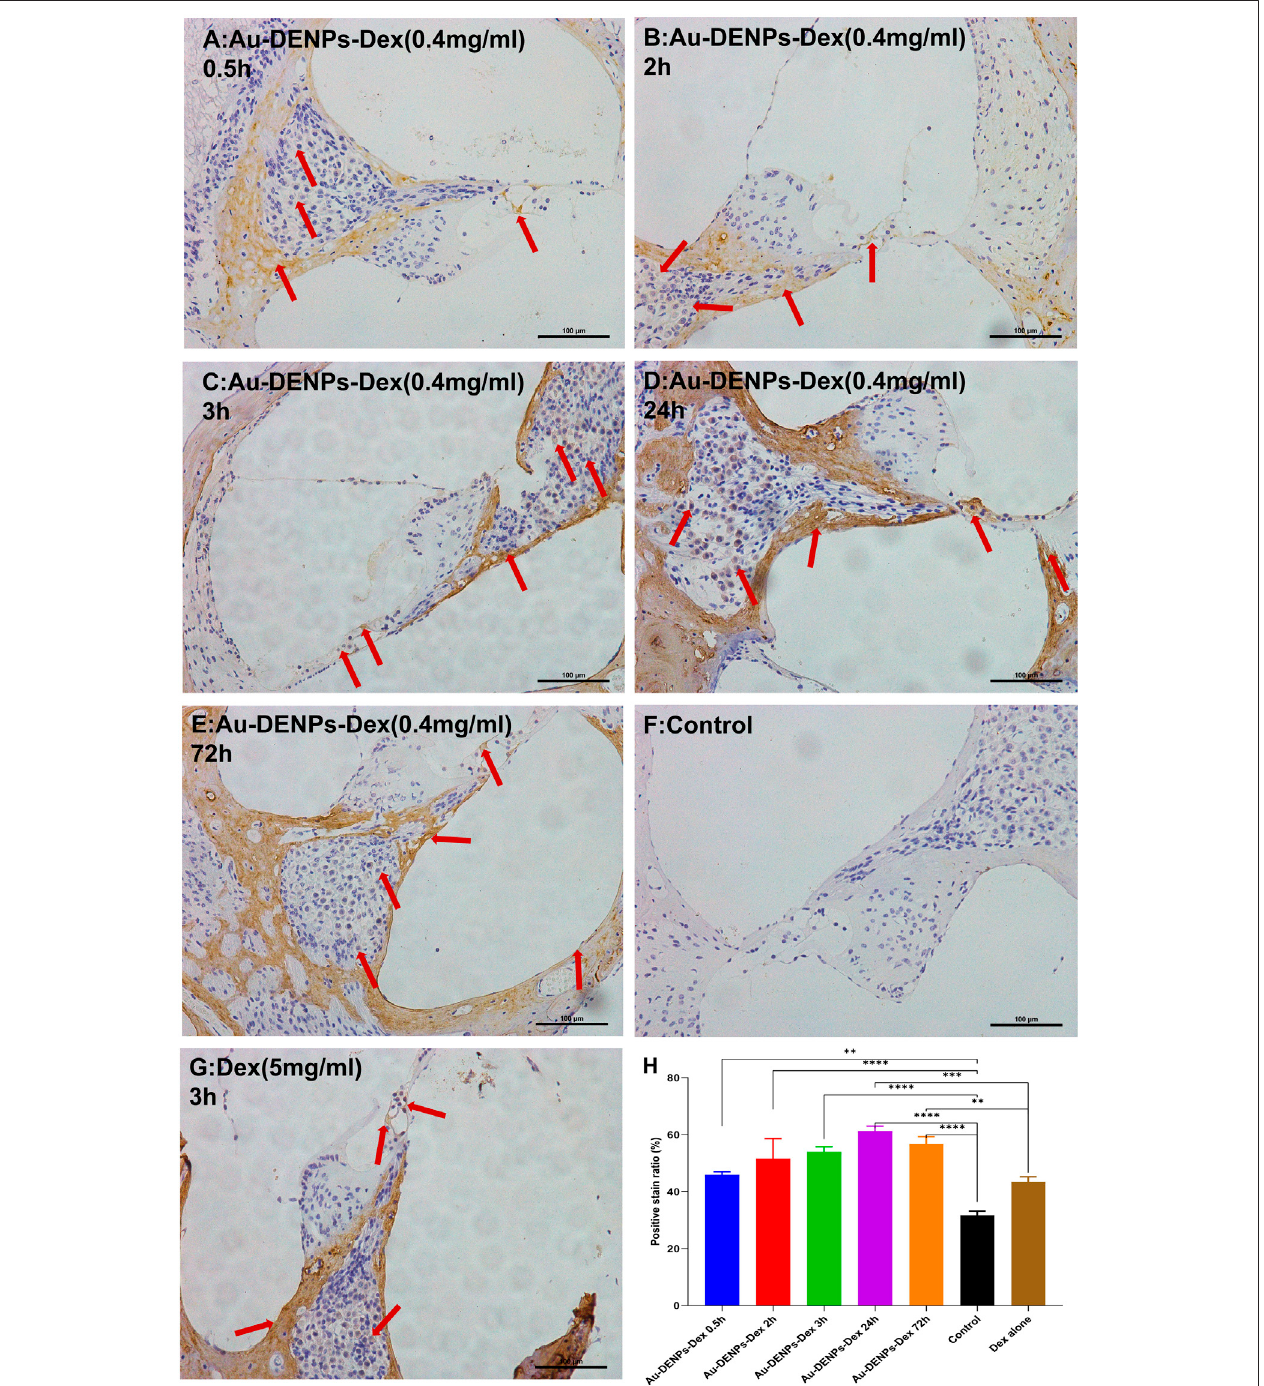
FIGURE4| Immunostainingfordexamethasone(Dex)afterinjectionofAu-DENPs-Dex,freeDex,andPBS. (A – E) TympanuminjectionofAu-DENPs-Dex(400 ug/ ml) for 0.5, 2, 3, 24, and 72 h, respectively. (F) Tympanum injection of 0.01 M PBS for the control group. (G) Tympanum injection of free Dex (5 mg/ml) for 3 h as a positive group. (H) positive staining rate of each group. * p < 0.05, ** p < 0.01, *** p < 0.001, and **** p < 0.0001.